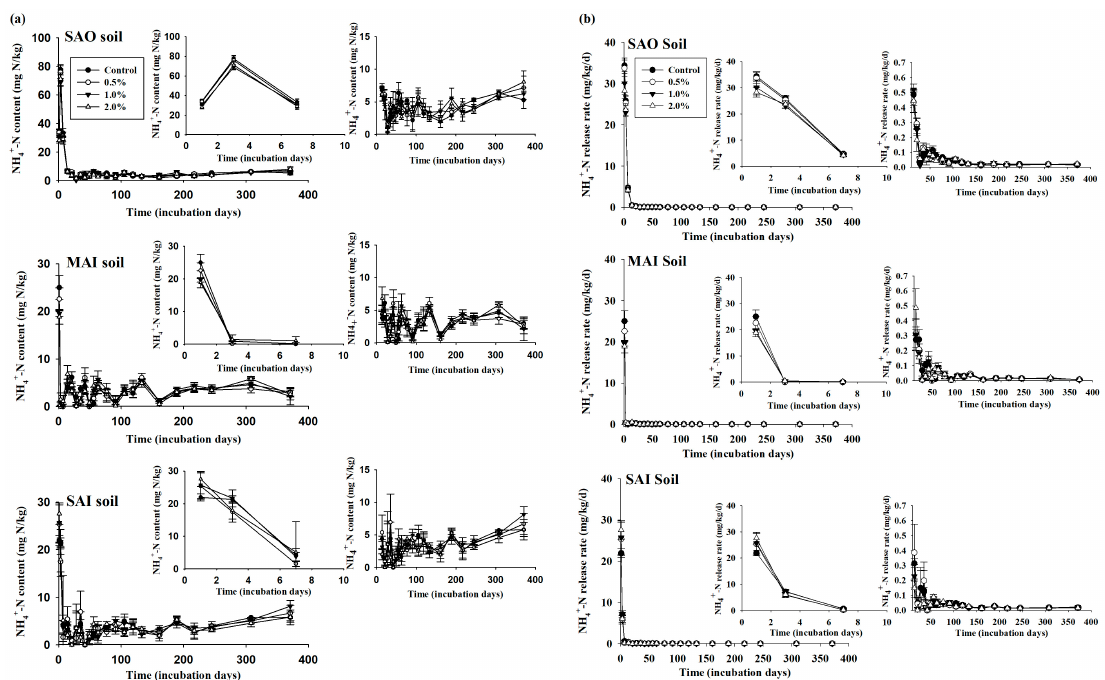
Figure 1. E ff ects of biochar additions on ( a ) NH 4 + -N content and ( b ) NH 4 + -N release rate. For each incubation time, release rate was calculated as the amount of release divided by the incubation time. The data are mean value ( n = 5), and vertical bars represent standard deviations (SDs) of the